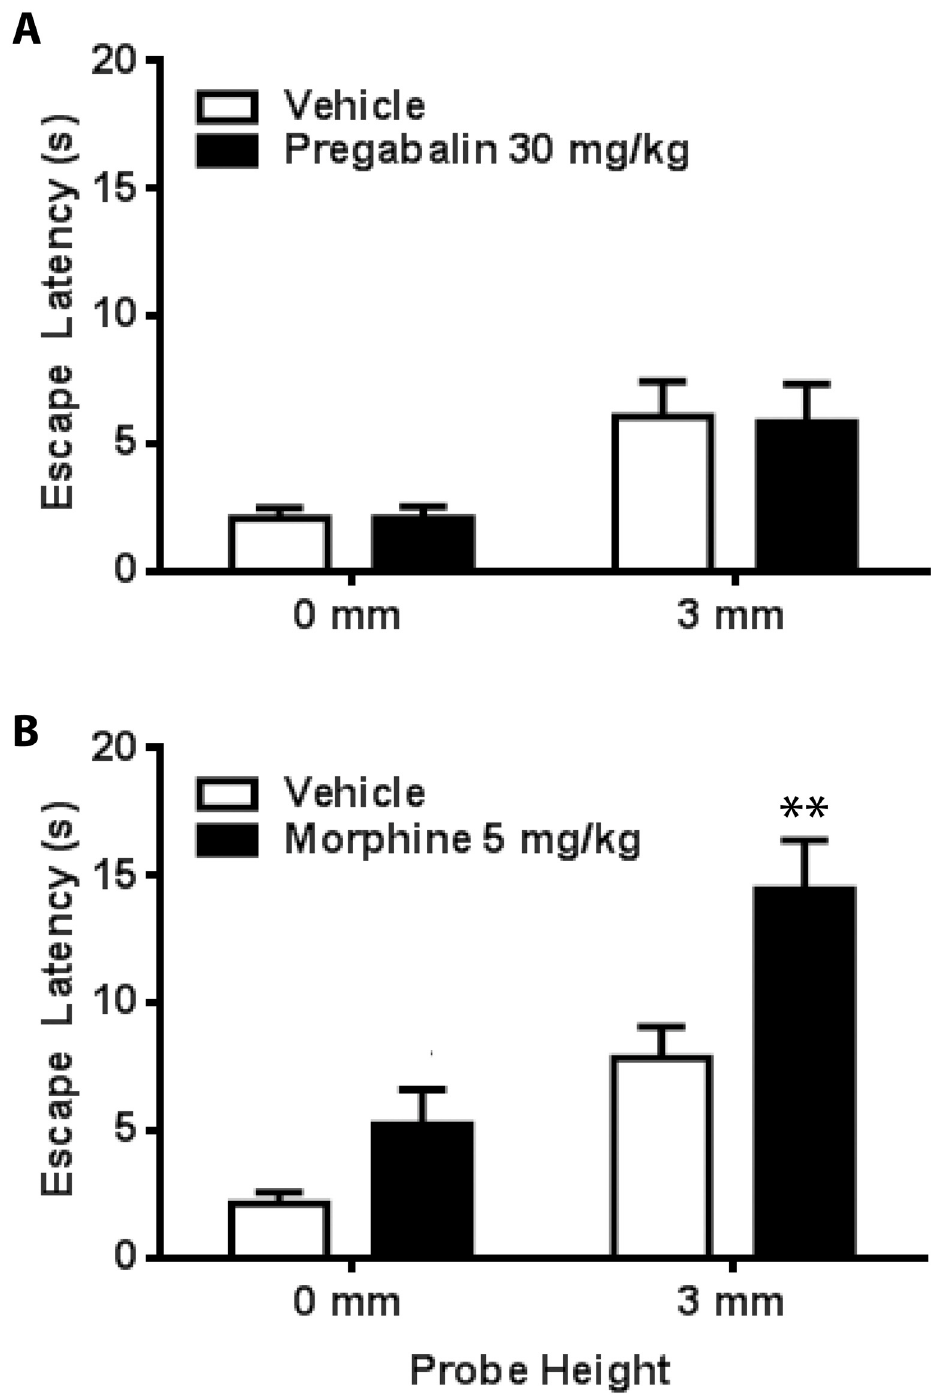
Fig 5. Effect of drug administration on escape latency in naive control rats. Pregabalin ( Panel A , n = 13) had not no effect on escape latency; whereas morphine ( Panel B , n = 12) increased escape latency. ** p < .01 compared to